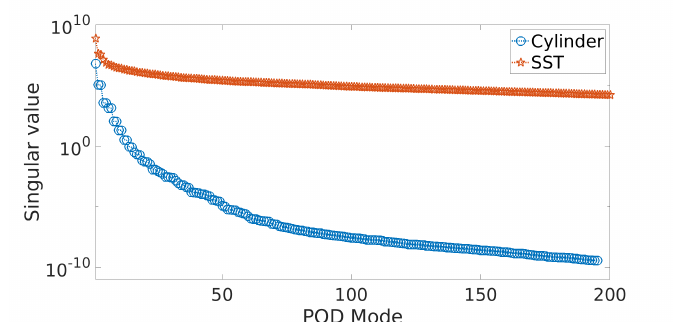
Figure 6. Singular value spectrum of the data matrix for both the cylinder wake flow at Re = 100 and the sea surface temperature (SST)